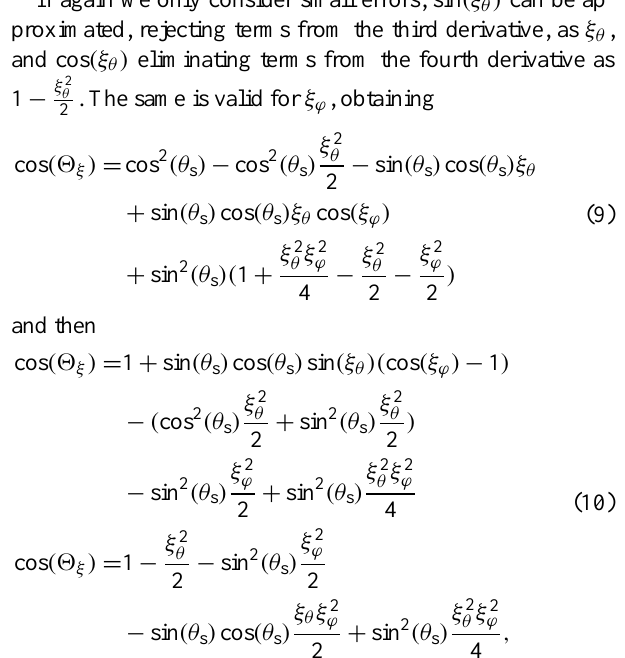
Fig. 1. Figure used to describe the pointing error. Dashed vector pointing towards the Sun represents the correct pointing while solid line represents a biased pointing. Shading areas are the projection of this error in spherical coordinates: ξ ϕ and ξ θ Θ ξ = Θ error ( ξ ϕ ,ξ θ ) = ξ θ ˆ θ +sin θ s ξ ϕ ˆ ϕ Θ ξ = q ξ 2 θ +sin θ s 2 ξ 2 ϕ